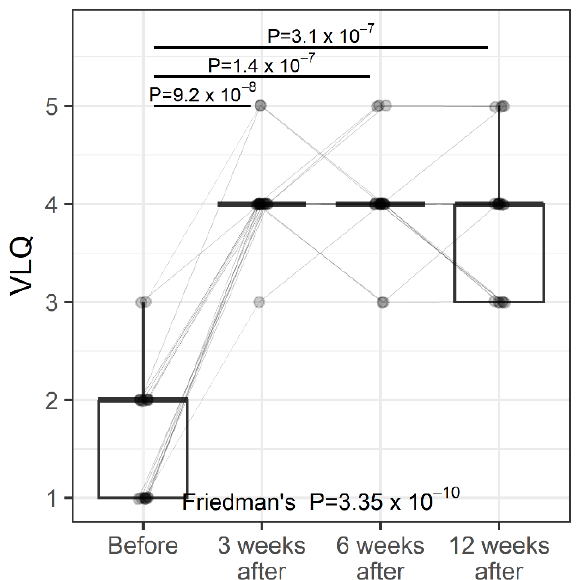
and summary Figure 1. VLQ (Vaginal Laxity Questionnaire) at study entry and follow-up visits (individual val- ues and summary statistics).